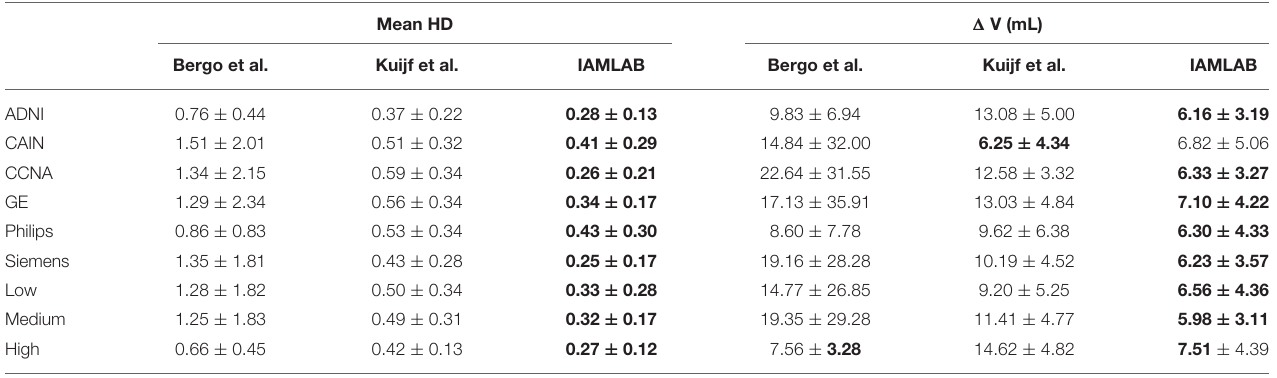
TABLE 4 | Mean ( ± std) of mean HD and mean volume difference for each dataset, scanner type and pathology level. Mean HD 1 V (mL) Bergo et al. Kuijf et al. IAMLAB Bergo et al. Kuijf et al. IAMLAB